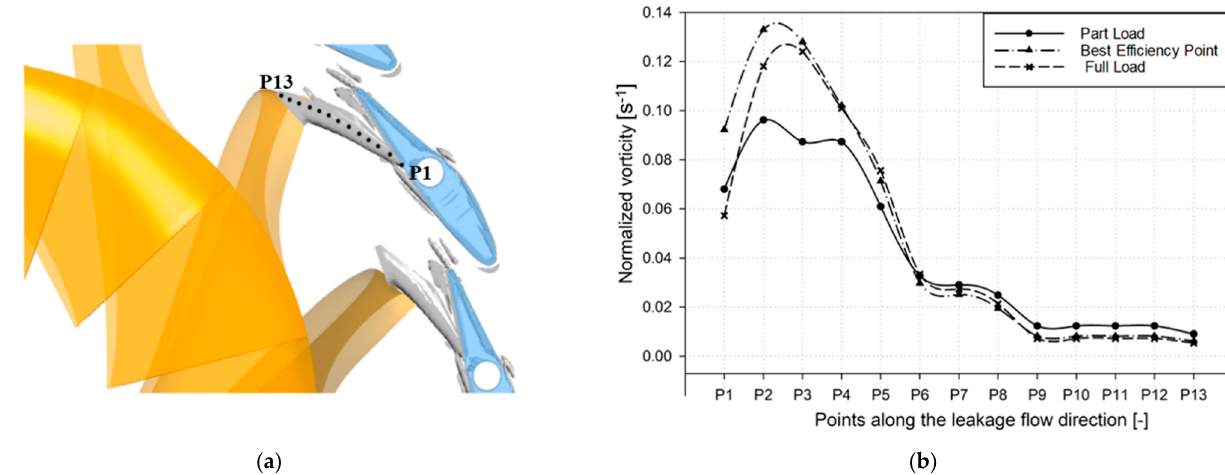
Figure 9. ( a ) LV pattern with 13 points along the trajectory for the calculation of vorticity value; ( b ) Vorticity graph normalized with corresponding BEP case along the LV trajectory.